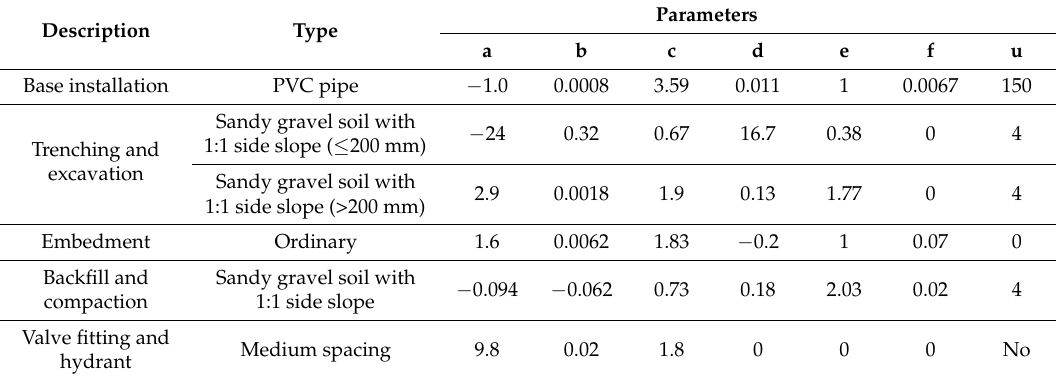
Table 1. Pipe CC parameters based on Clark et al.